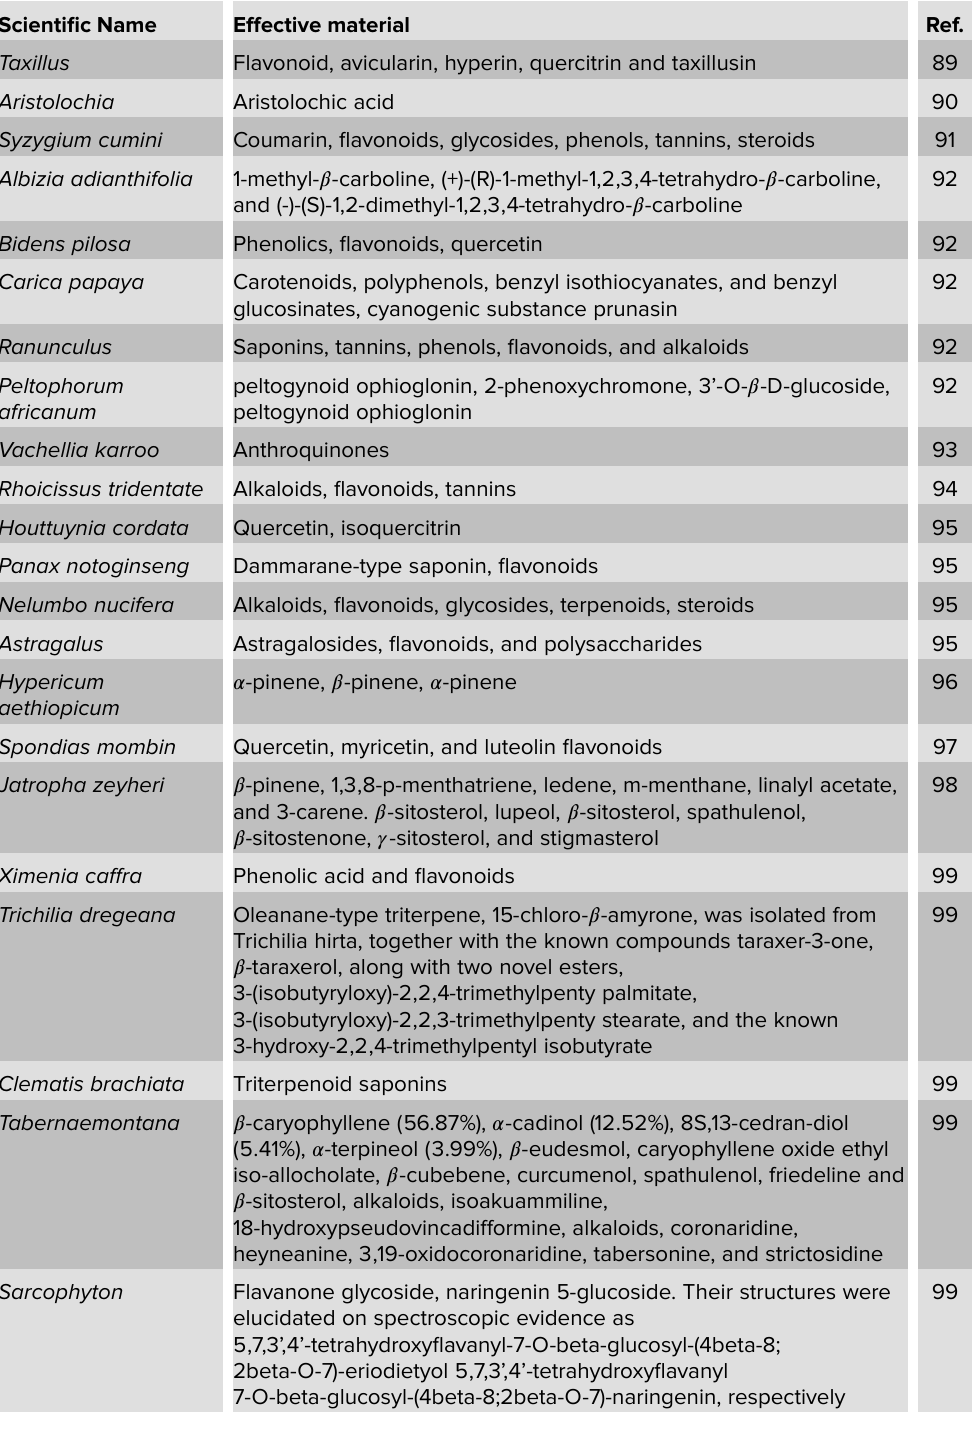
Table 2: Effective material of the herbal